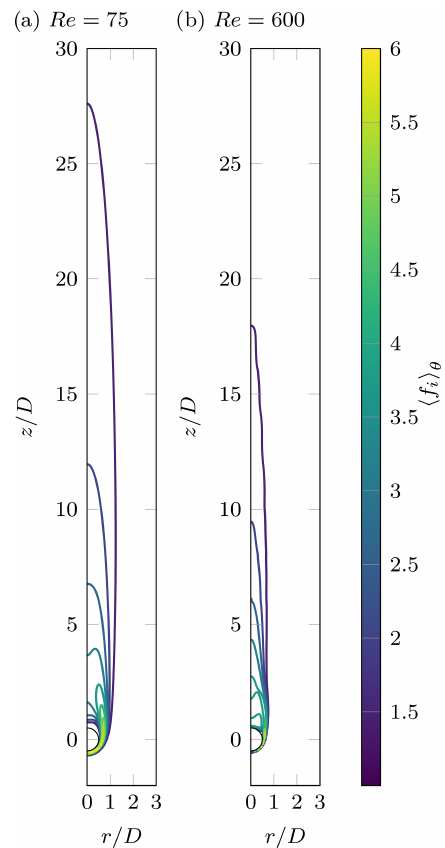
Figure 7. Contours of local ice enhancement factor in the wake, av- eraged over time and azimuthal direction at T ∞ = − 15 ◦ C. (a) Ax- isymmetric regime at Re = 75. (b) Chaotic regime at Re =